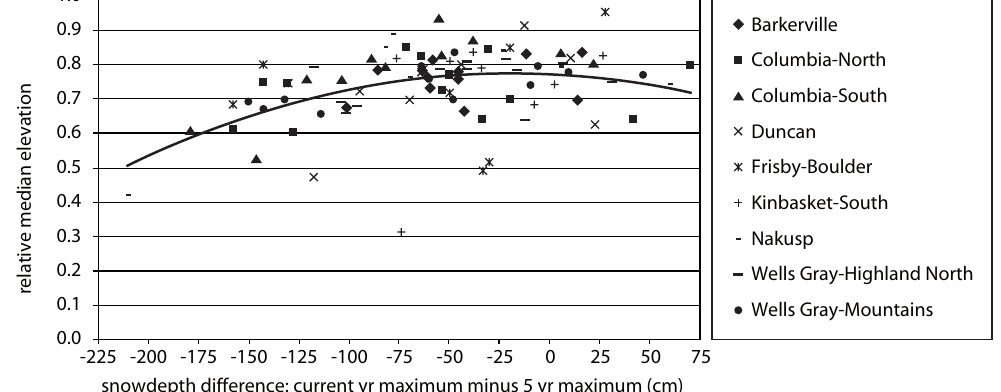
Fig. 2. Relative elevation in relation to relative snow depth for mountain caribou in the wet and very wet climatic regions ( n = 9 subpopulations, 91 subpopulation-years). Relative elevation = (median elevation for late winter – 1 st percentile of winter elevation for all years combined) / (99 th percentile - 1 st percentile of winter elevation). Trend line is 2 nd -order polynomial for all